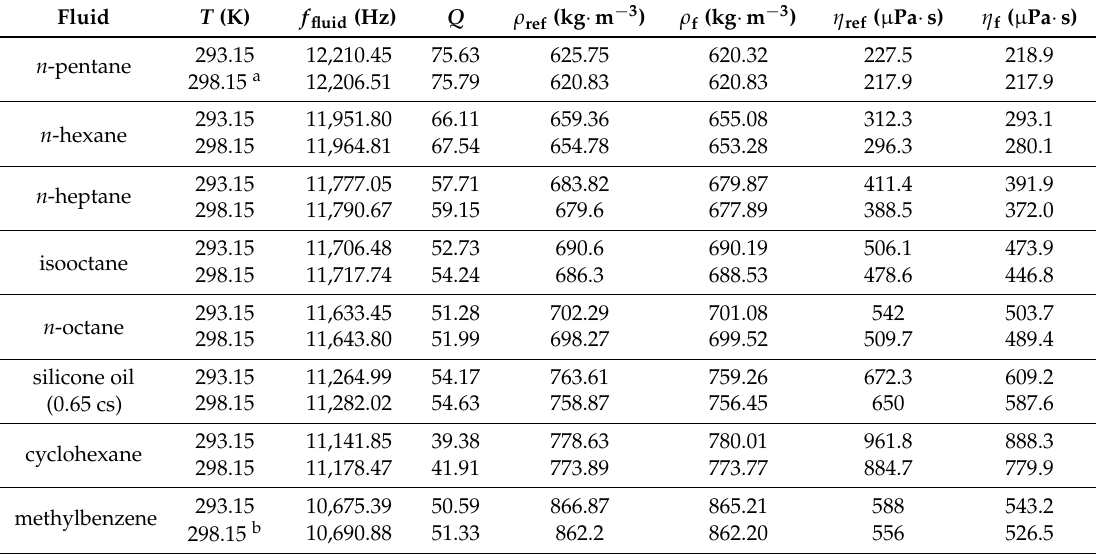
Table 2. Experimental results of rectangular micro-cantilever chip under torsional resonant mode. Fluid T (K)